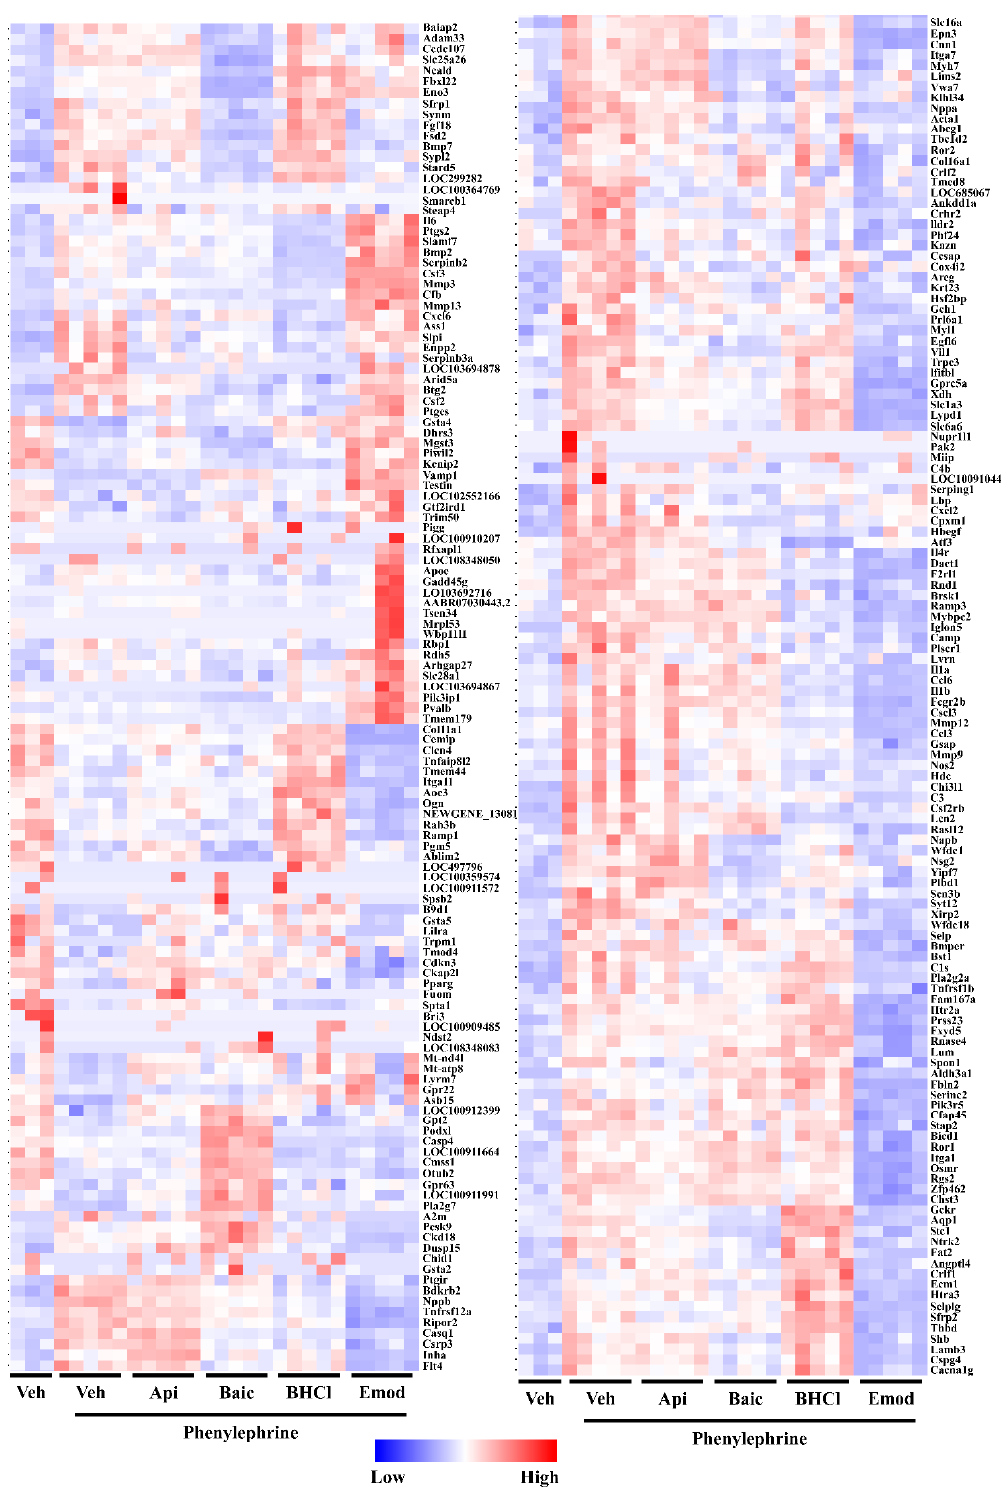
Figure 3. Phytochemicals regulate divergent and overlapping gene pathways in response to PE-induced cardiac hypertrophy. NRVMs were stimulated to hypertrophy with phenylephrine (PE; 10 µ M) in the absence or presence of vehicle control